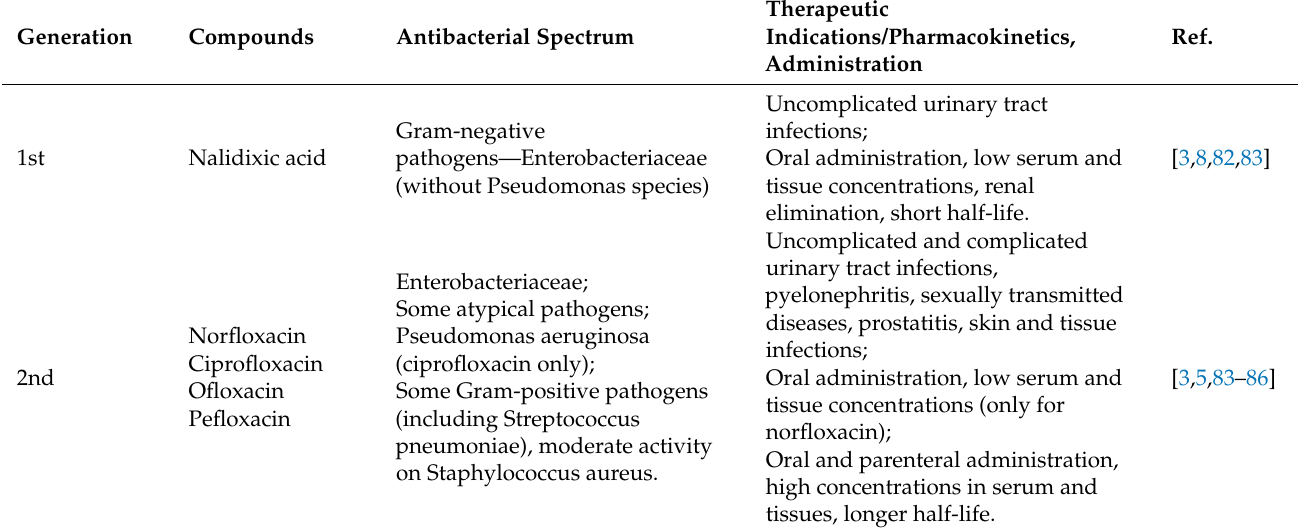
Table 2. Classification into generations of the main FQNs for human use in therapy based on antibacterial spectrum and therapeutic indications (FDA and EMA